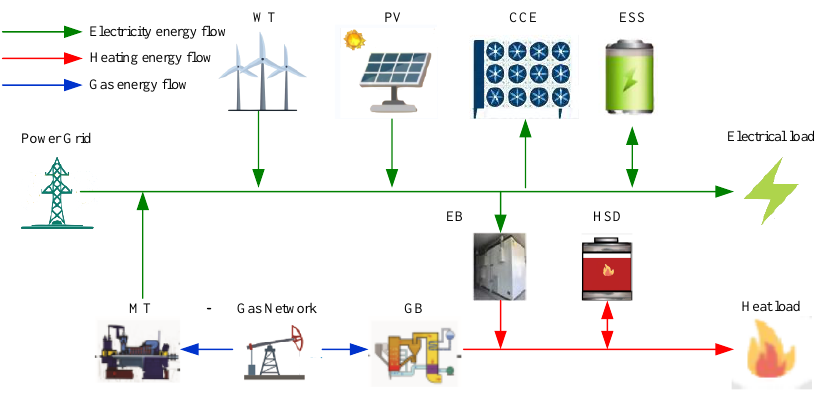
Figure 1. Internal structure diagram of PIES.